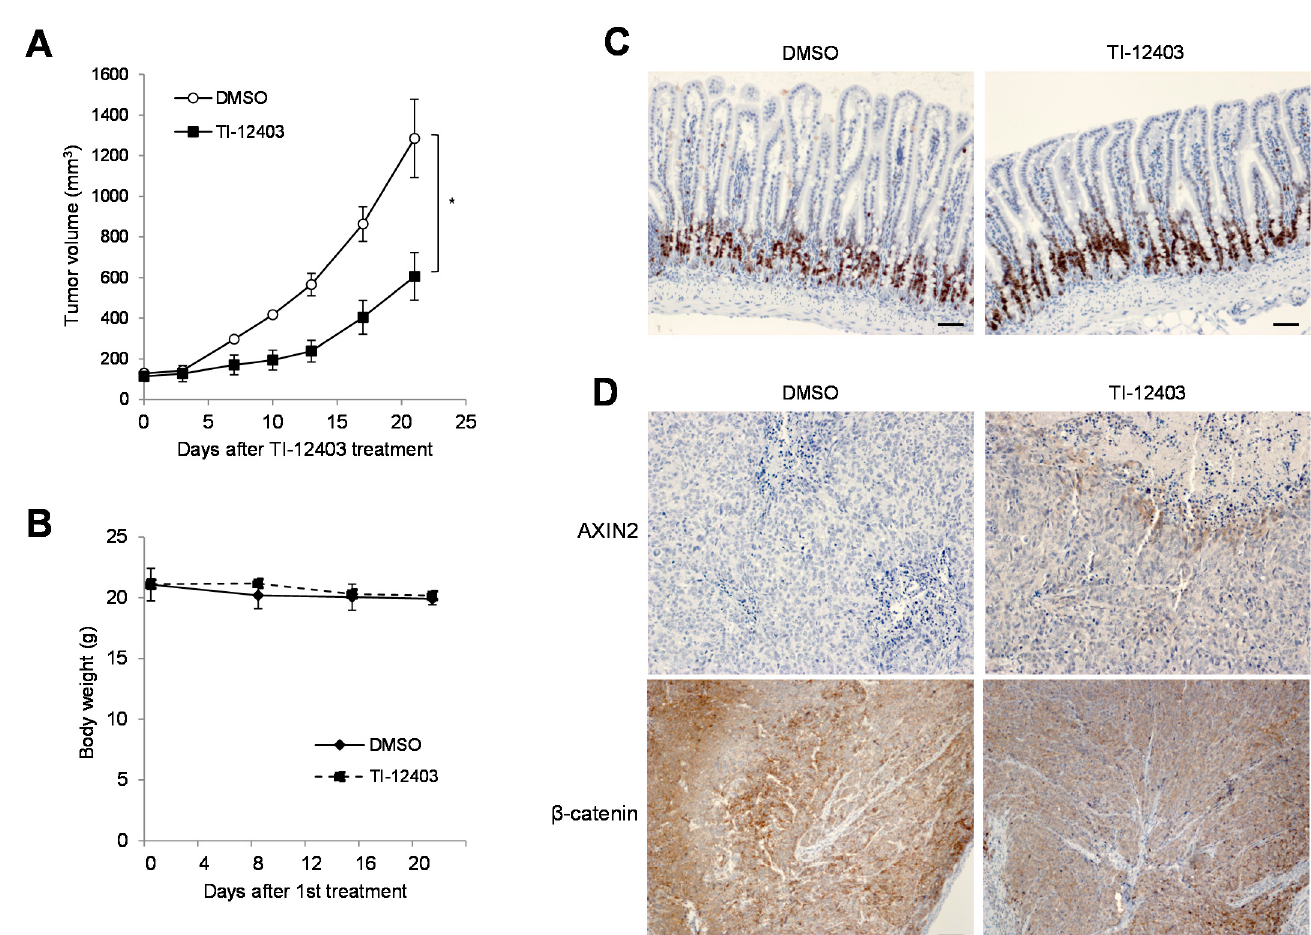
Figure 4. TI-12403 suppressed the growth of DLD-1 xenograft tumors in nude mice. ( A ) DLD-1 cells were subcutaneously injected into the thigh of the right hind leg of BALB/c nu/nu mice (n = 4 per group). One week after tumor cell injection, TI-12403 (20 mg/kg) or DMSO (control) was intraperitoneally administered once per day for 14 days. The longest (L) and shortest (W) tumor axes were measured, and tumor volume (mm 3 ) was calculated as L × W 2 /2. The data shown represent the average tumor volume (* p < 0.05). ( B ) Body weights of DLD-1 tumor xenograft mice were determined once weekly during the experiments. ( C , D ) Xenograft tumors and small intestines in each group were harvested and extracted completely after 21 days. ( C ) Small intestine sections from TI-12403- or DMSO-treated DLD-1 xenograft mice were immunohistochemically stained with the cell proliferation marker Ki67 (brown). Scale bar, 100 μ m. ( D ) Immunohistochemical staining of β -catenin and AXIN2 (brown) in tumor tissues. Scale bar, 100 μ m.